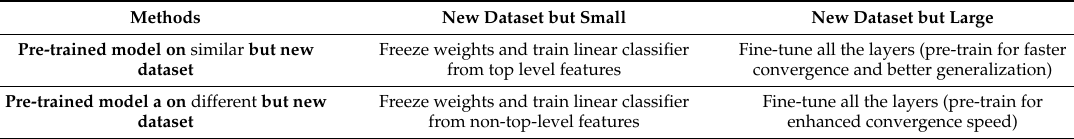
Table 3. Criterions need to be considered for transfer